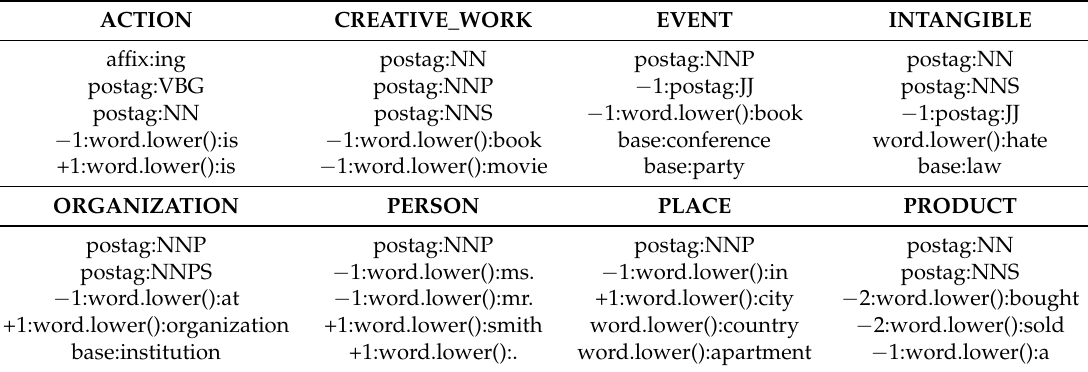
Table 2. Most prominent features of each class detected during the training phase.